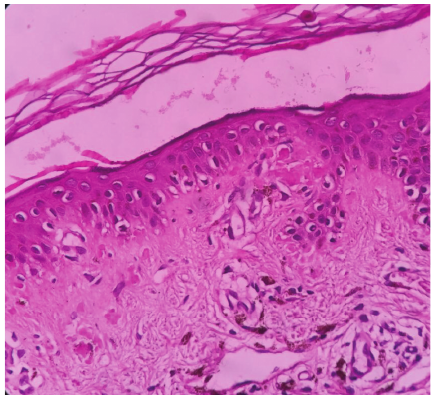
Figure 2: Small globular hyaline materials of amyloid in the papillary